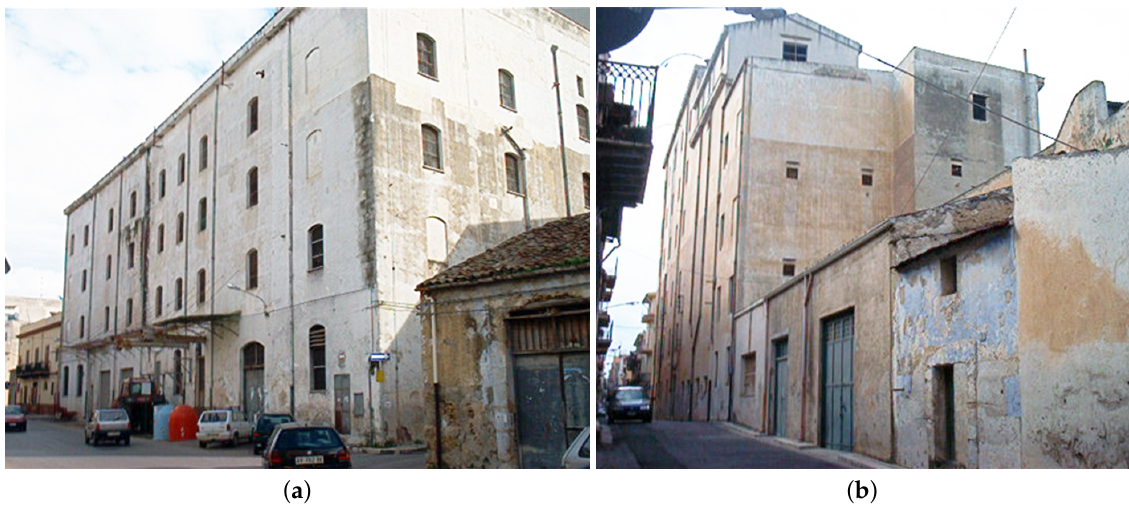
Figure 7. Building exterior views. ( a ) Main front; ( b ) Secondary